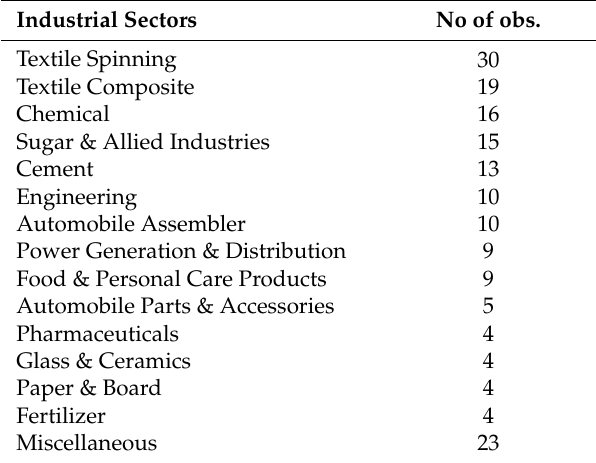
Table 2. Industrial Sectors of Sample